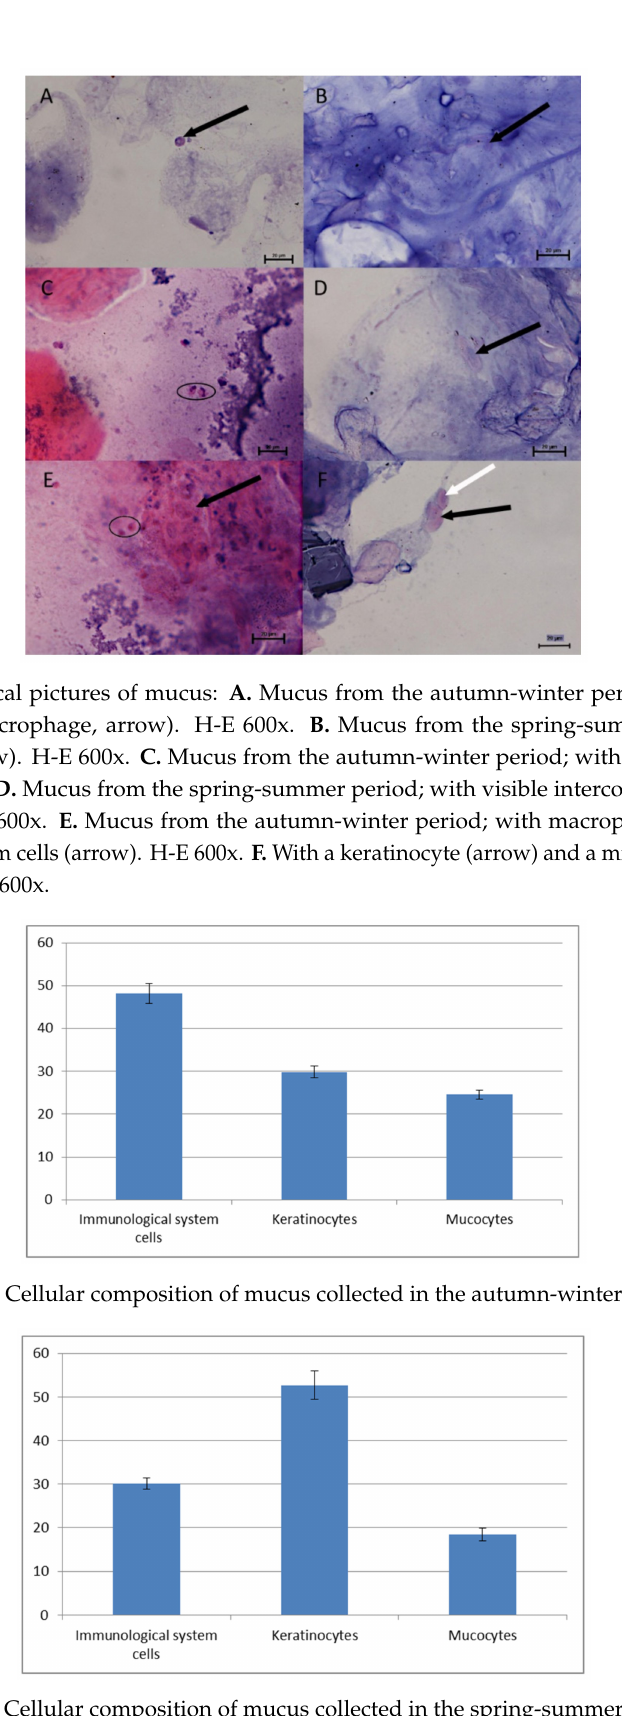
Figure 8. Cellular composition of mucus collected in the spring-summer